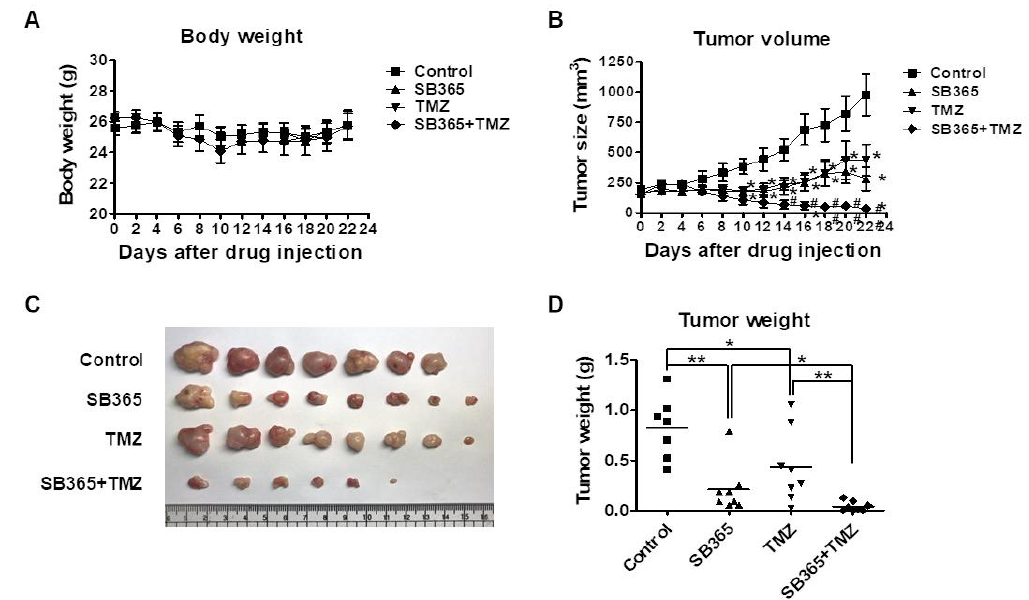
Figure 7. Combination of SB365 with TMZ additively suppressed the growth of U87-MG tumors in a mouse xenograft model. U87-MG cells were subcutaneously inoculated into both flanks of nude mice. When the tumor reached a volume of ~100–200 mm 3 , mice were intratumorally administered with SB365 every other day and / or with TMZ intraperitoneally daily for 22 days. The control received vehicle ( < 3% DMSO). ( A ) Body weight and ( B ) tumor size were measured every other day. The mice were euthanized, and ( C ) the tumors were extracted and ( D ) weighed. n = 8 per group. * p < 0.05 and ** p < 0.01 vs the control. SB365, SB365-treated group; TMZ, temozolomide-treated